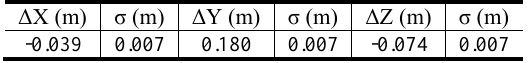
Table 1. Lever arm coordinates and their standard deviations.